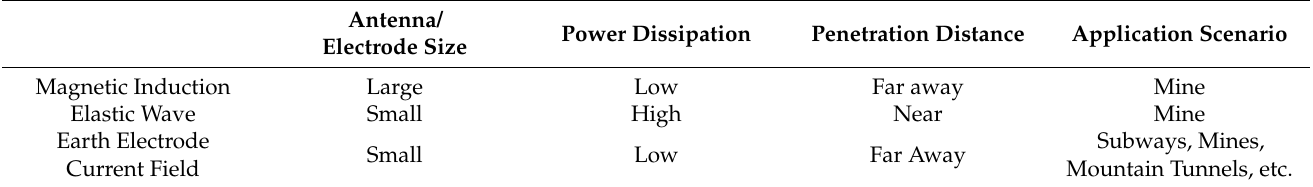
Table 1. Comparison of characteristics, advantages, and disadvantages of three types of wireless strong-penetration information transmission